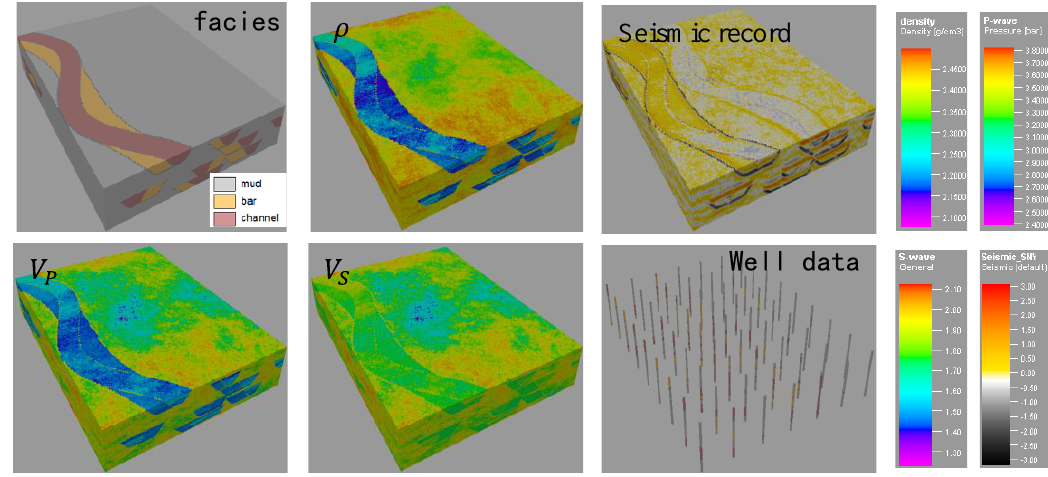
Figure 2. Stanford VI-E theoretical model.